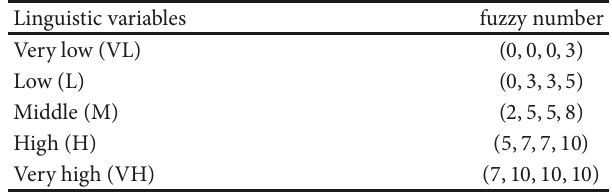
Table 2: Language variables and fuzzy numbers for